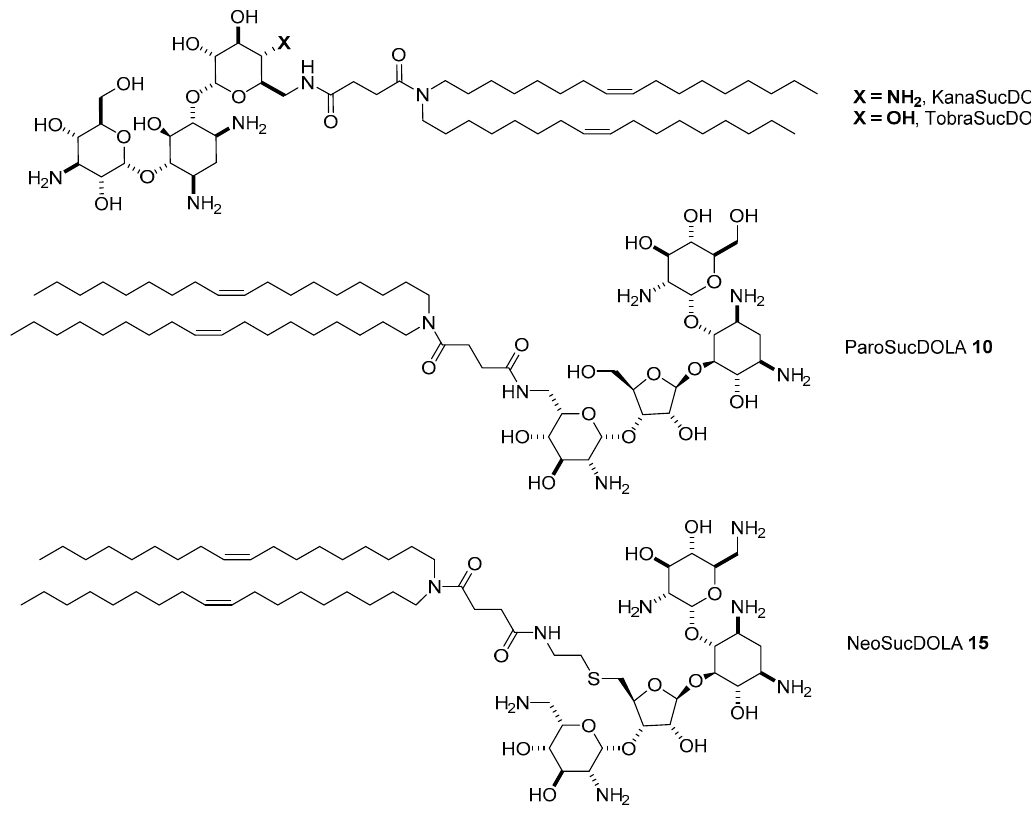
Figure 10. Aminoglycoside-based lipids tested as siRNA delivery vectors .